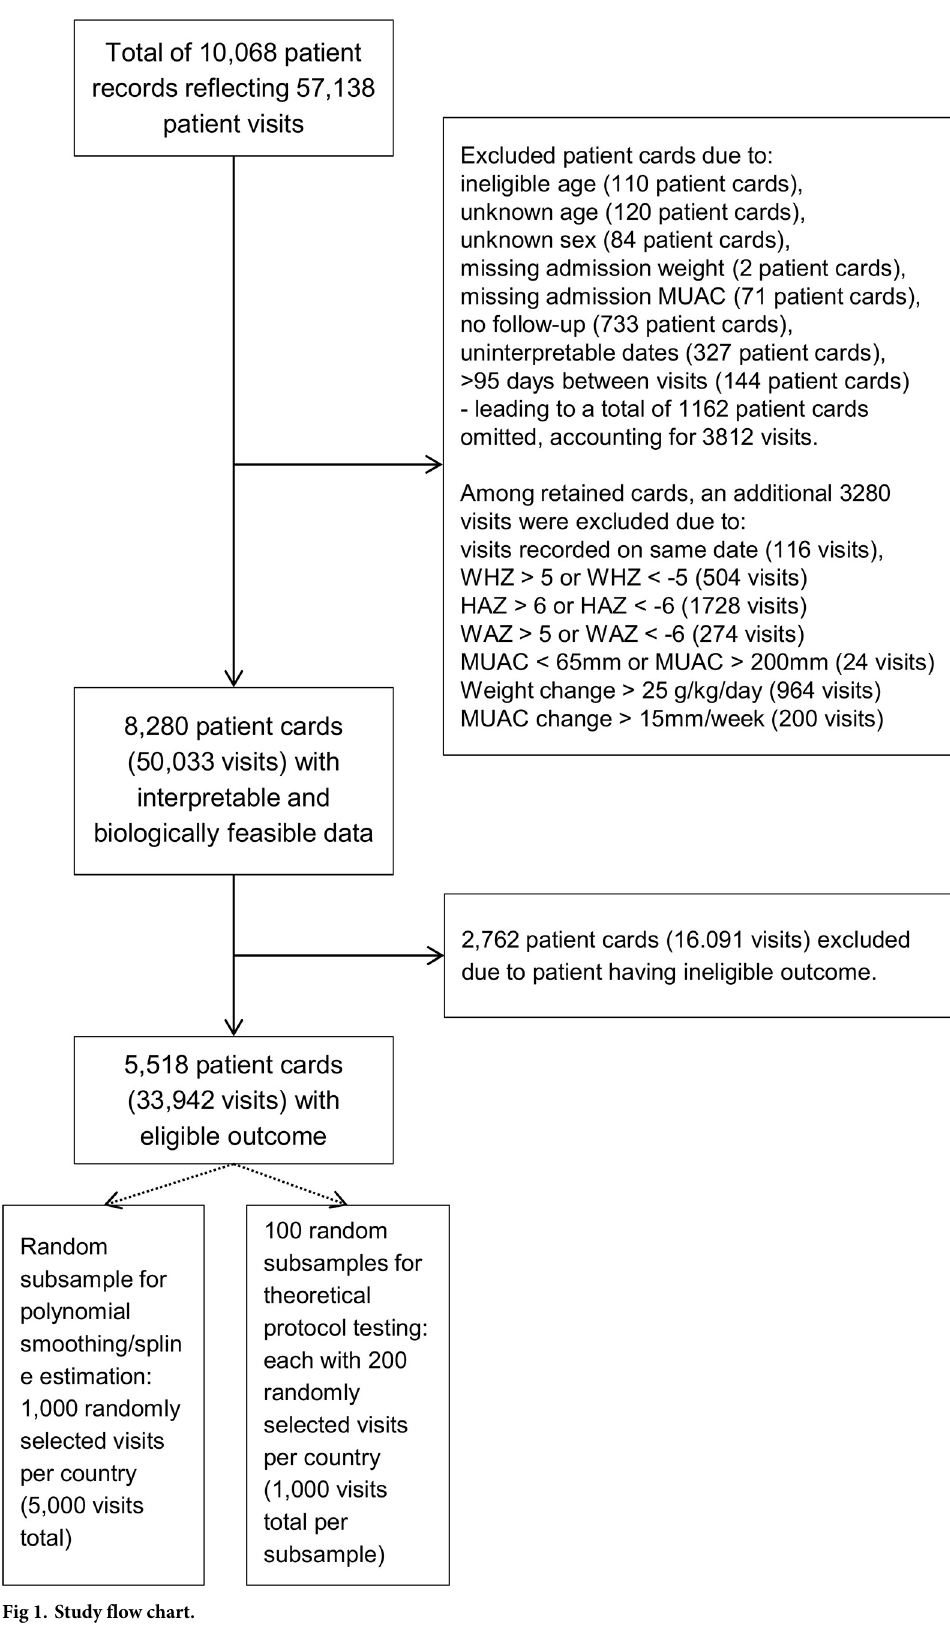
Fig 1. Study flow chart. https://doi.org/10.1371/journal.pone.0230452.g001 PLOS ONE | https://doi.org/10.1371/journal.pone.0230452 June 3,